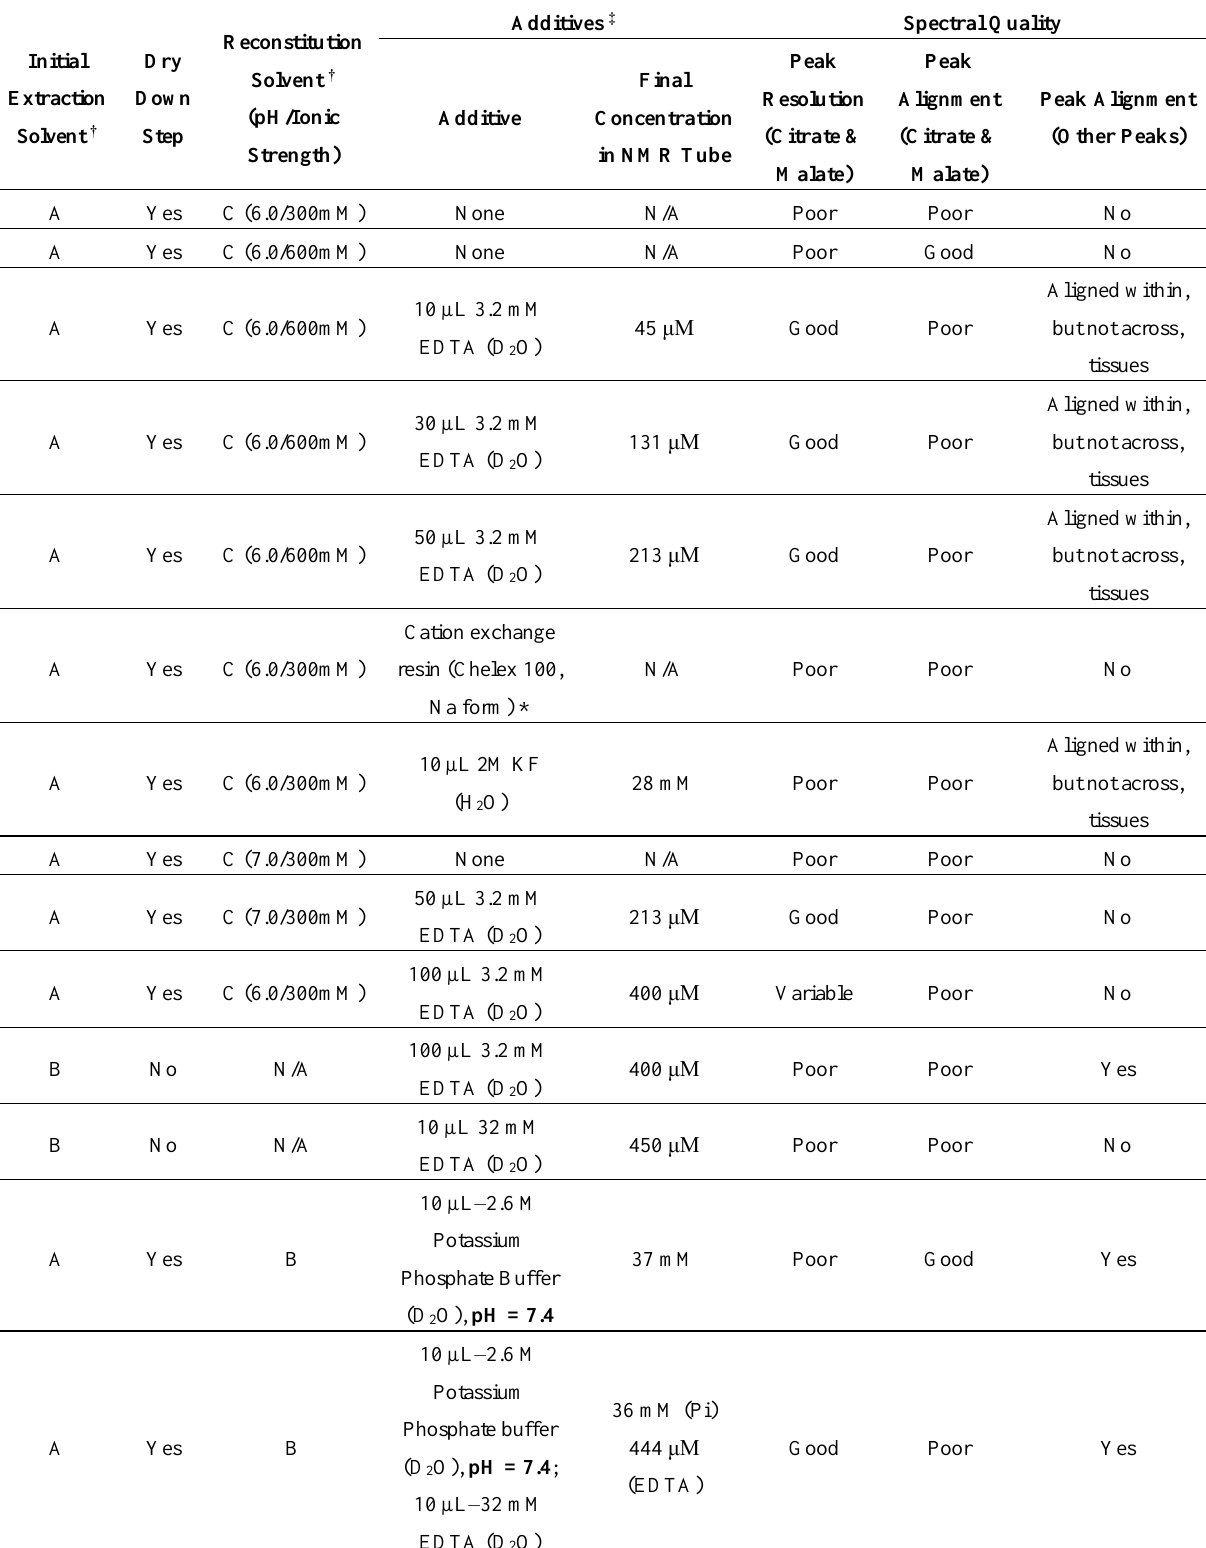
Table 1. Matrix of methods attempted to align and sharpen willow 1D 1 H-NMR signals. Initial